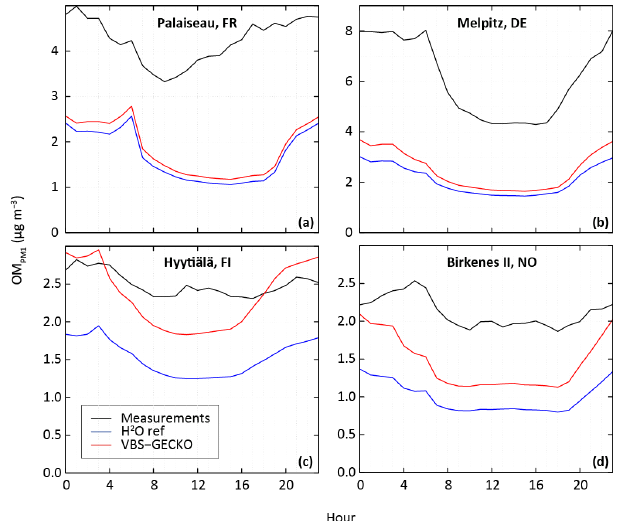
Figure 4. Measured (black) and simulated mean diurnal pro- file (in UTC) with the H 2 O model configuration (blue) and the ref-VBS-GECKO model configuration (red) for OM PM centration at stations influenced dominantly by anthropogenic sources (Palaiseau (a) and Melpitz (b) ) and by biogenic sources (Hyytiälä (c) and Birkenes II (d)